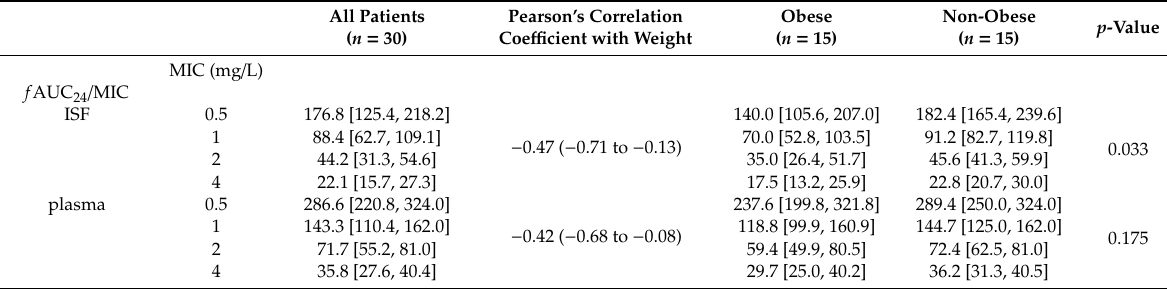
Table 3. Linezolid exposure in the interstitial fluid of subcutaneous adipose tissue and plasma relative to clinically relevant MIC values. Entries are the median [interquartile range] or estimate (95% confidence interval). The p -values refer to comparisons of the obese and non-obese groups. f AUC = area under the concentration–time curve of unbound concentrations; ISF = interstitial space fluid; MIC = minimal inhibitory